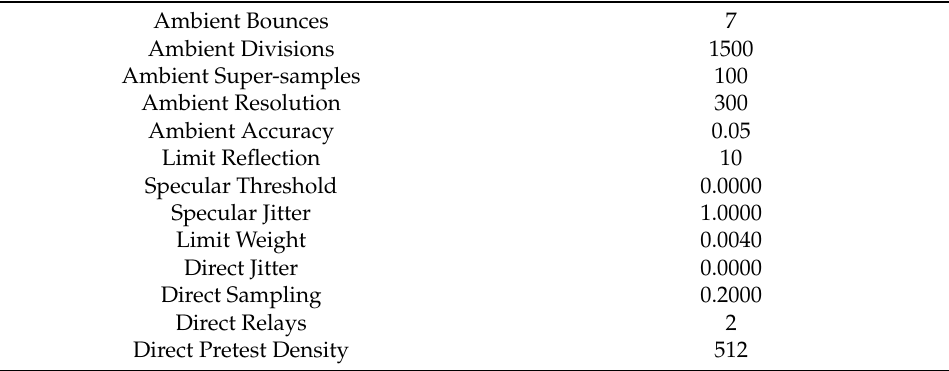
Table 1. Parameters of the calculation program